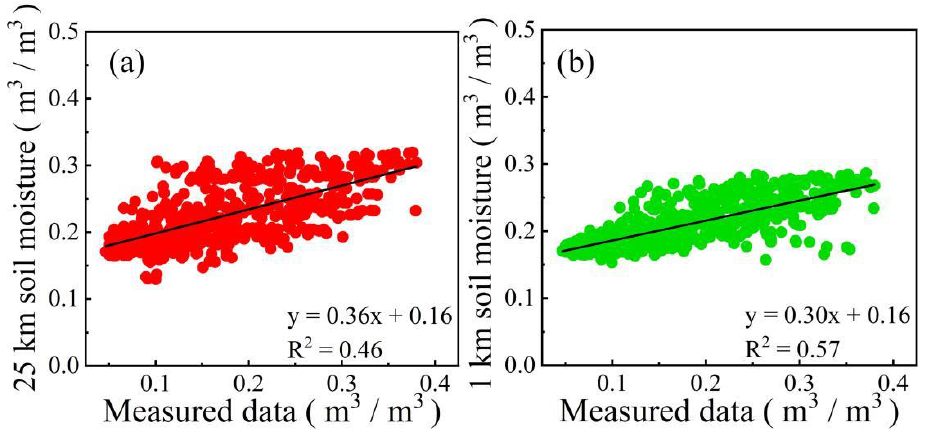
Figure 2. Comparison of ( a ) GLDAS-2.1 products, and ( b ) downscaled SM with field measures, re- spectively.